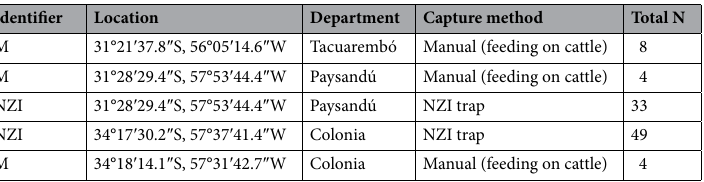
Table 2. Location and capture method used for the nonsystematic horsefly collections in Uruguay.